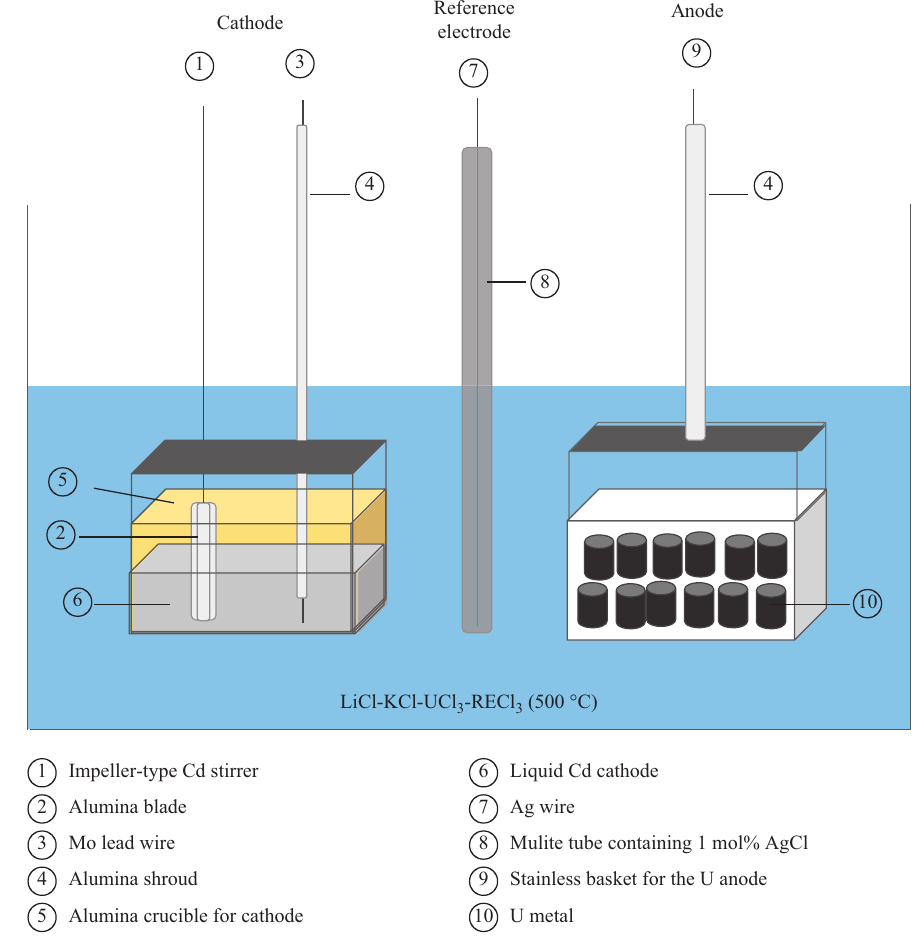
Figure 1: Schematic of the experimental